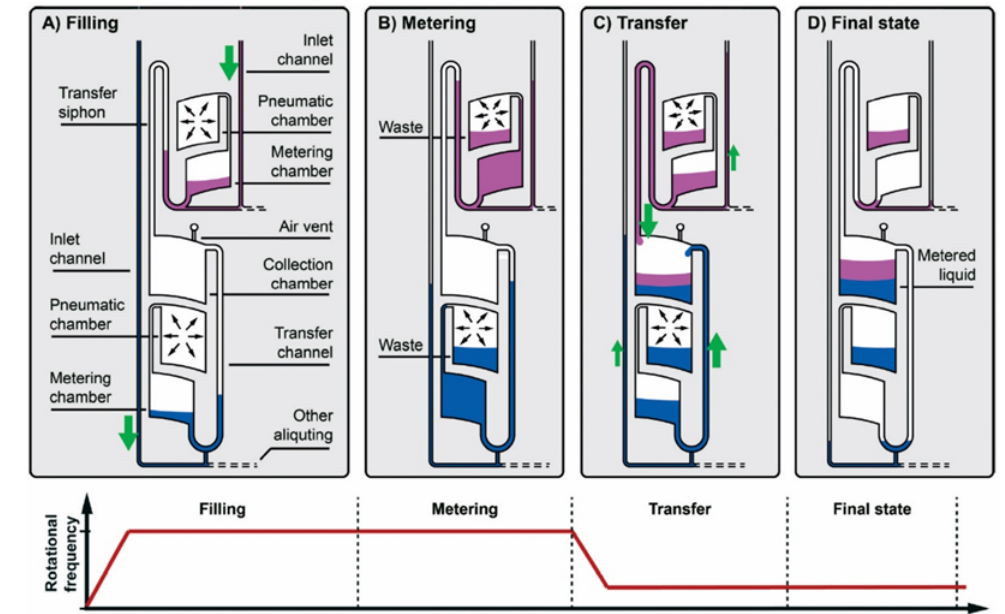
Figure 5. Principle of centrifugo-pneumatic metering. Figure reprinted with permission from [63].